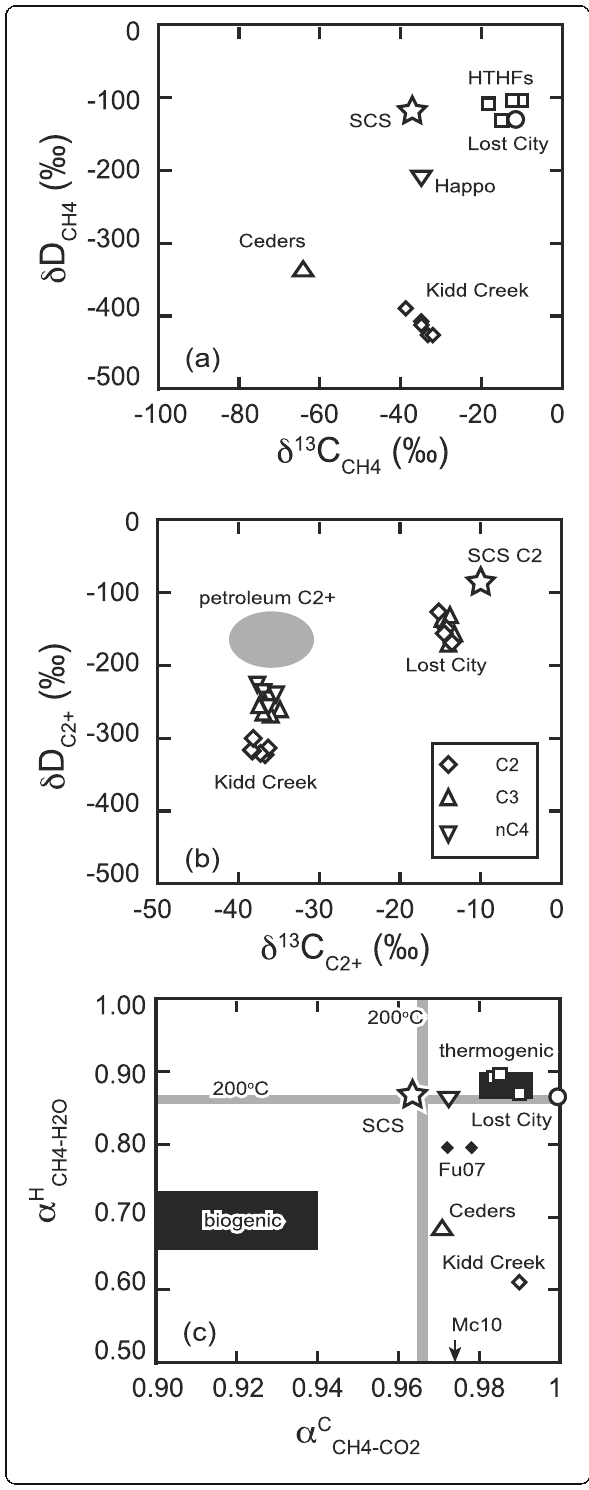
Fig. 5 Stable isotope composition of CH 4 , C 2 H 6 , and the relevant molecules. Open and filled symbols, respectively, represent data from observations of hydrocarbon-enriched geofluid systems and experiments simulating methanogenesis. Data sources are following: high-temperature hydrothermal fluids (Konn et al. 2015; Kawagucci et al. 2016 and references therein), Lost City (Proskurowski et al. 2006; 2008), Happo (Suda et al. 2014), The Ceders (Wang et al. 2015), Kidd Creek (Sherwood-Lollar et al. 2002), petroleum field (Burruss and Laughrey 2010), magnetite experiments (Fu et al. 2007), Fe experiment (McCollom et al. 2010), thermogenic experiment (Seewald et al. 1994) (assuming the CH 4 -H 2 O isotope equilibrium), and microbial incubation (Okumura et al.